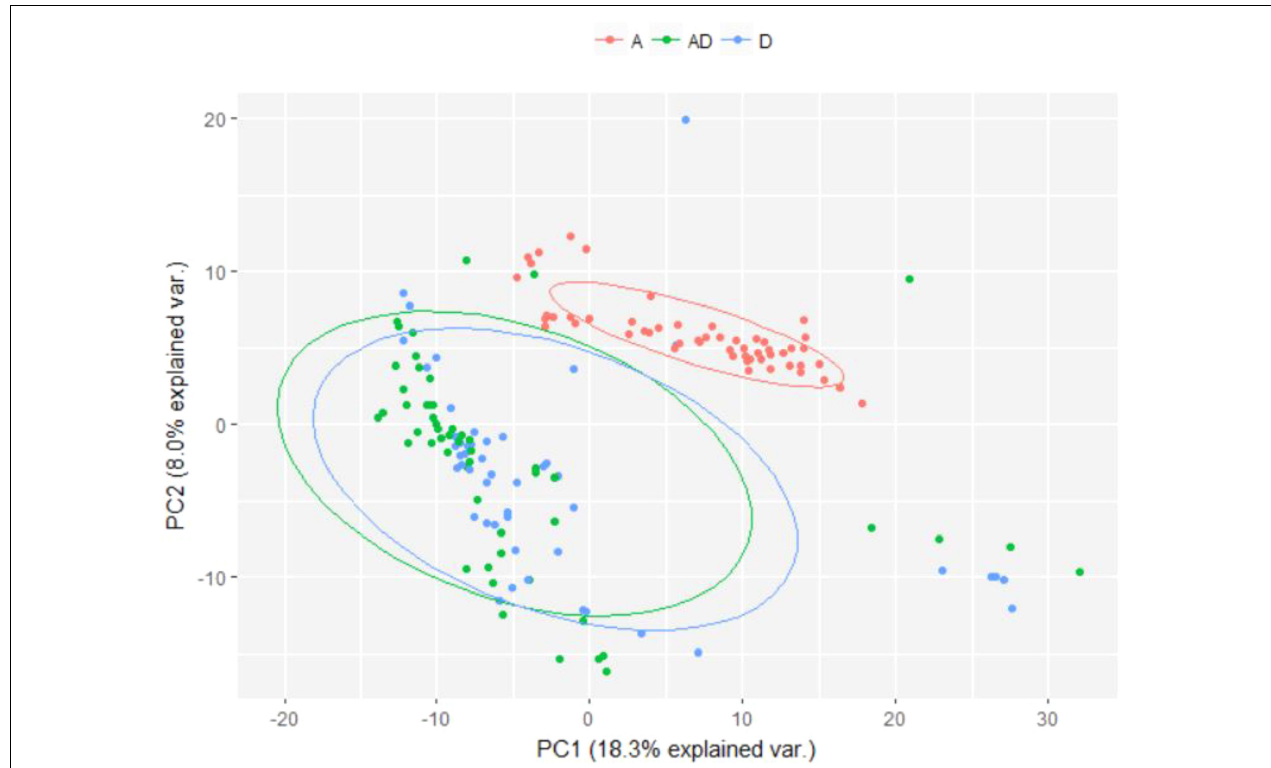
FIGURE 6 | PCA plot showing differences in microbial composition between soil samples subjected to different perturbation regimes. Samples from day 0 were excluded, as no treatment was applied yet. A, Ammonium; D, Soil drying.